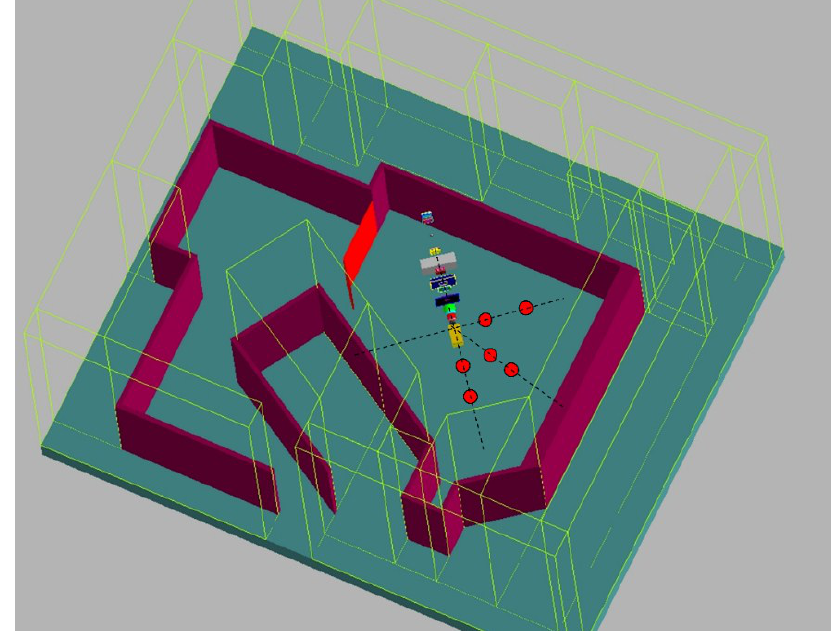
Figure 2. Geometry of a proton therapy system for ocular treatments and positioning of the neutron equivalent dose meters along the three axes at 0°, 45° and 90° with respect to the proton beam